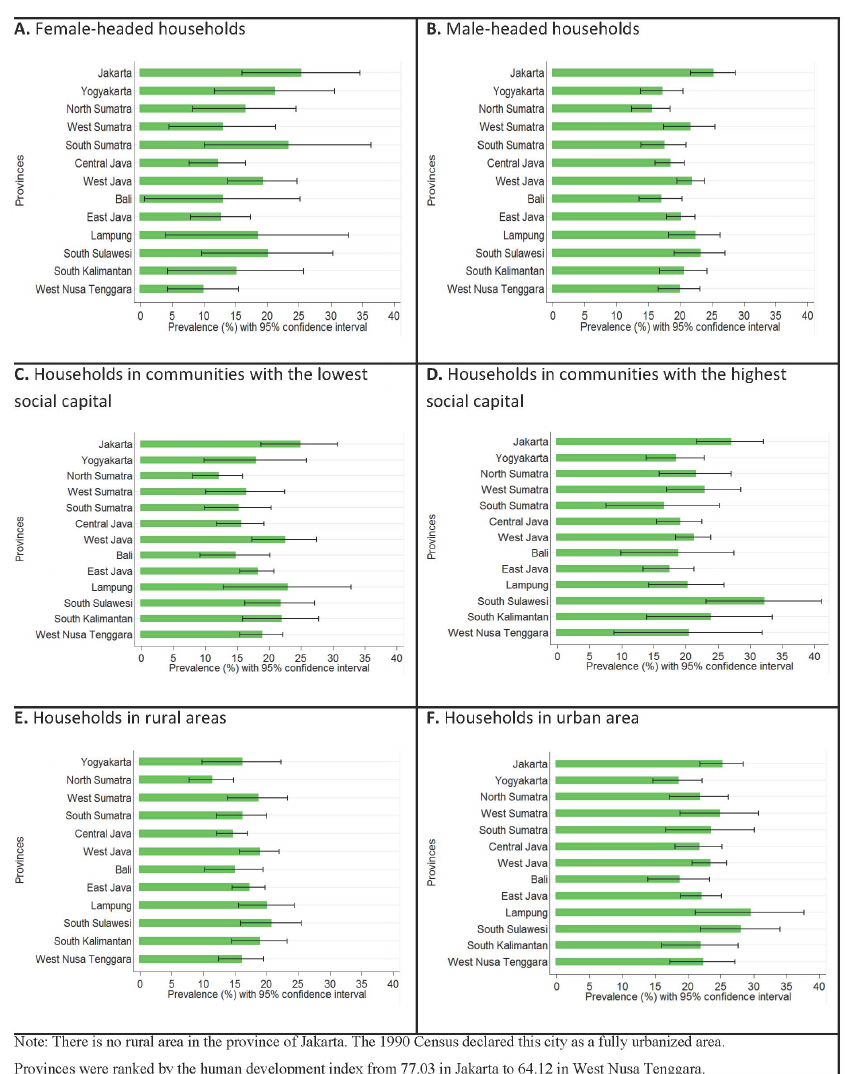
Figure 3. The prevalence of dual burden of malnutrition across provinces in Indonesia in households with different characteristics based on the head of household gender, community social capital, and type of area.